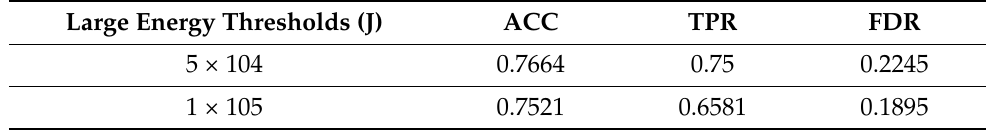
Table 4. Cross- working face performance test